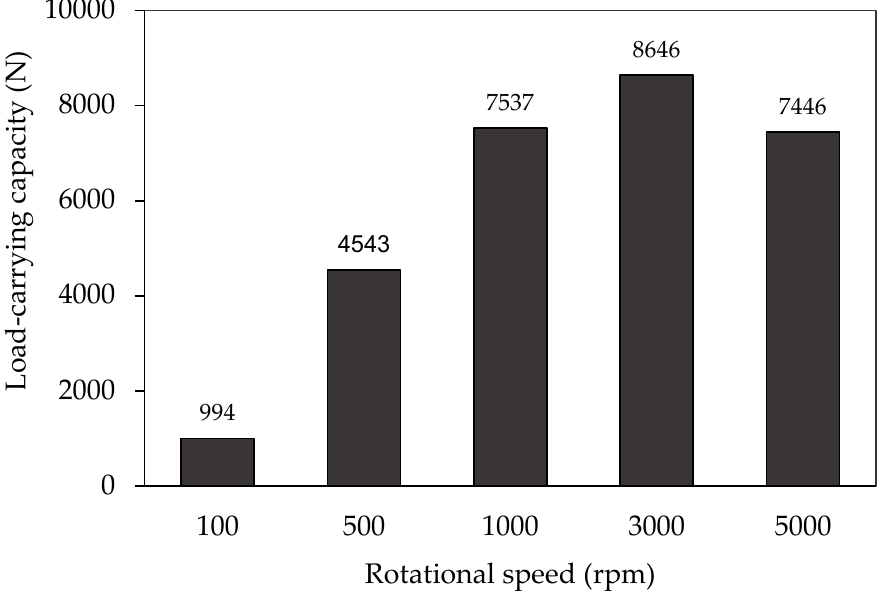
Figure 17. Load-carrying capacity of the heterogeneous slip/no-slip bearing for different rotational velocity n . All results are evaluated at z / L = 0.5.